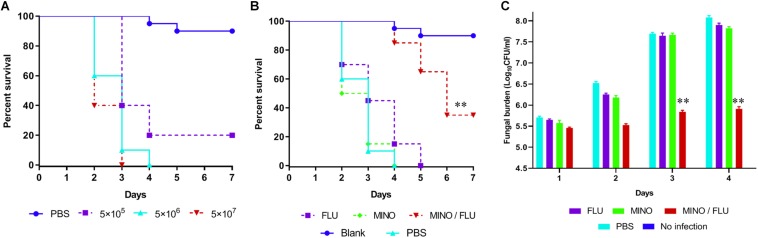
Survival rate and fungal burden of CN526-infected G. mellonella larvae treated with different drugs. (A) Different concentrations of CN526 (5 × 105, 5 × 106, and 5 × 107 cells/larvae) were used to infect the G. mellonella larvae (20 larvae for each group) to determine the ideal inoculum concentration. The survival rates for each group were calculated. (B) CN526 (5 × 106 cells/larvae) was used to infect the G. mellonella larvae (20 larvae for each group). Three hours after infection, the larvae were treated with 5.2 mg/kg FLU (FLU group), 6.3 mg/kg MINO (MINO group), or a combination of 5.2 mg/kg FLU and 6.3 mg/kg MINO (MINO/FLU group); the PBS group was used as a control. Treatment was administered only once. Another group (No infection group) that was injected with 10 μl of sterile PBS instead of CN526 was used as a negative control. The survival rate was calculated daily. (C) Experimental groups were established and treated as described in (B). Every day, three larvae from each group were randomly selected and homogenized to determine the C. neoformans burden via inoculating dilutions of the homogenized caterpillars onto SDA solid medium plates, as described above. The data shown are the means of three independent experiments, and they were analyzed using a log-rank test. ∗∗p < 0.01, compared with the FLU-treated group.